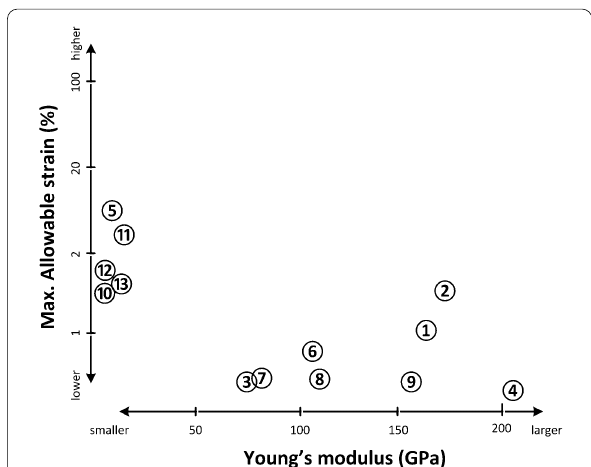
Figure 13 Graph of Young’s modulus vs. maximum allowable strain of the materials in the 13 process-material